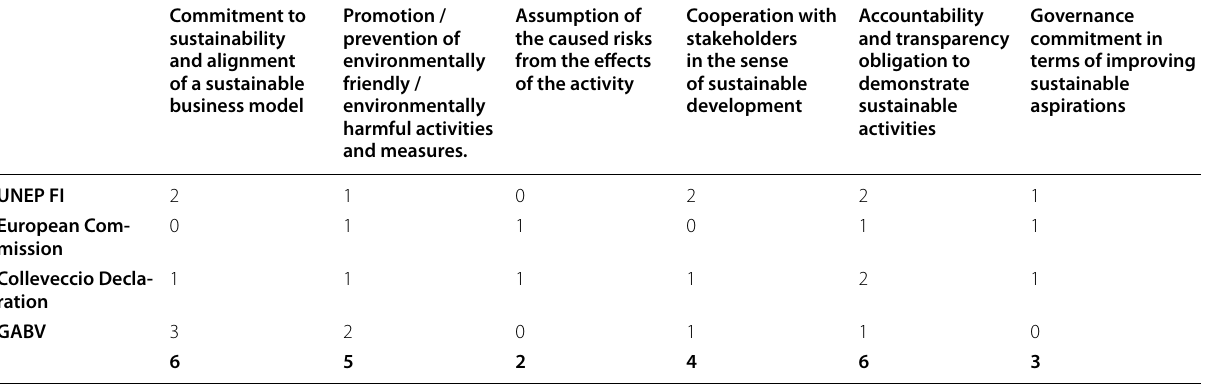
Table 4 Mention of the categories from the key statements